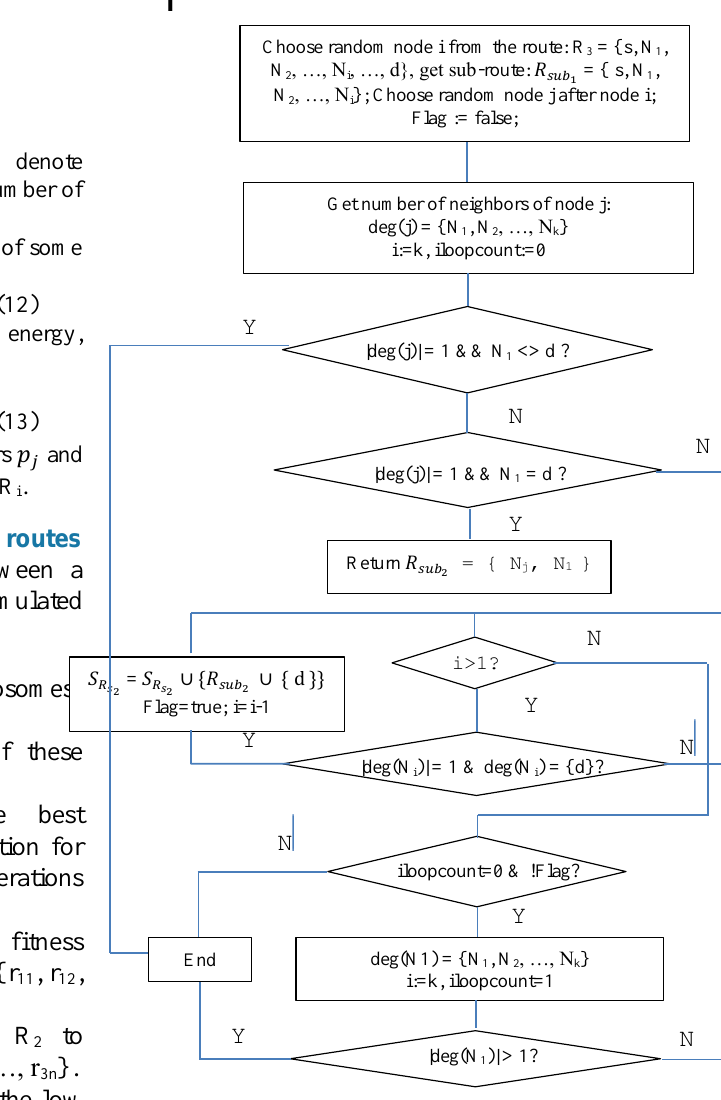
Figure 5 . Algorithm for choosing a